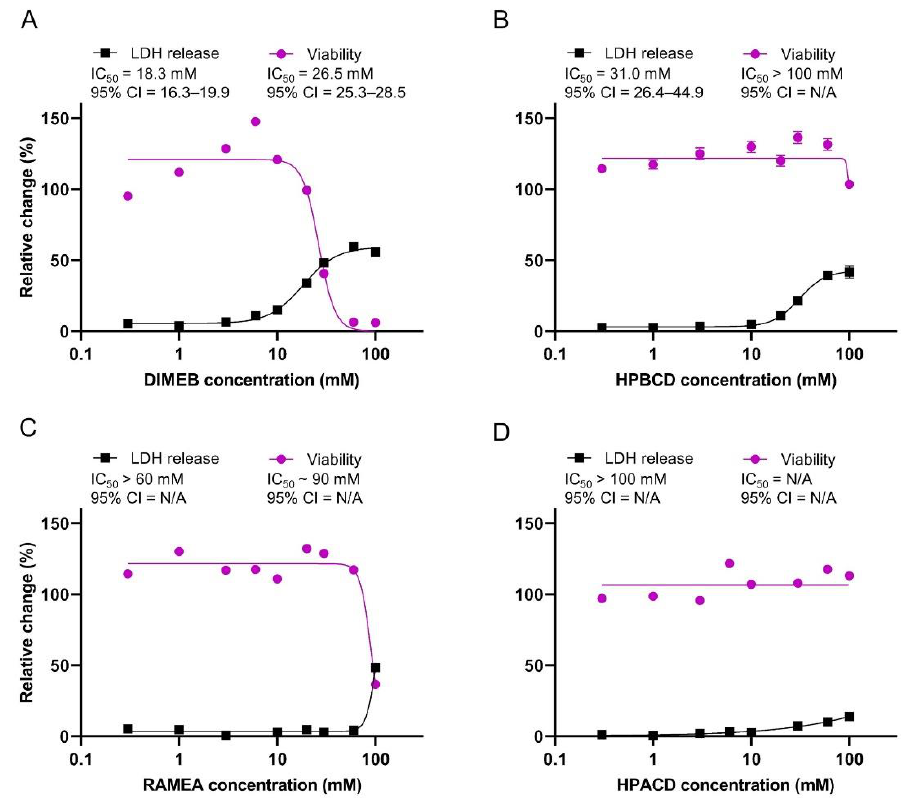
Figure 2. The effect of DIMEB ( A ), HPBCD ( B ), RAMEA ( C ), and HPACD ( D ) on the membrane integrity and viability of the rat cerebral synaptosomes. Synaptosomes were analyzed after 40 min exposure to cyclodextrins. For estimating membrane integrity, LDH release from synaptosomes was calculated as percentage of total LDH content determined by Triton X-100 lysis. Viability was measured by resazurin reduction assay and values are expressed as the percentage of vehicle- treated synaptosomes. IC 50 values and their 95% confidence intervals (95% CI) are given. Data are represented as means ± SEM (n = 3). N/A means non